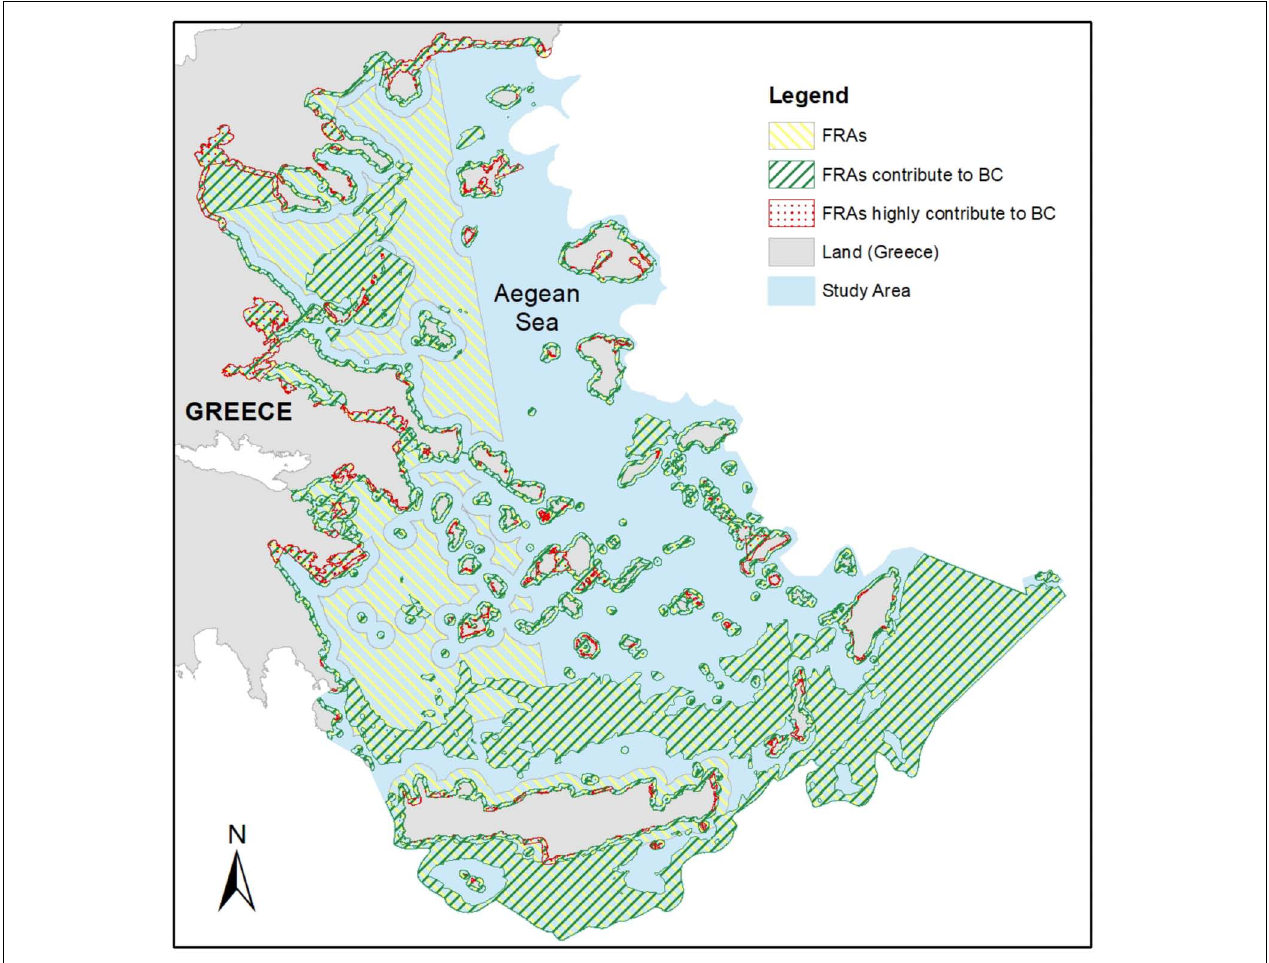
FIGURE 7 | Fisheries restricted areas (FRAs) in the Aegean Sea (Greek territorial and international waters). BC, biodiversity